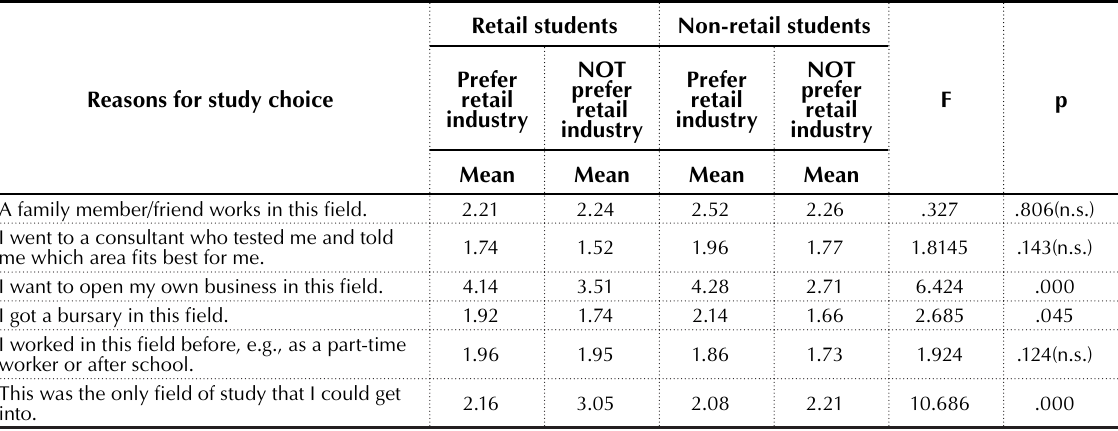
Table 7. Studentsʼ reasons for study choice